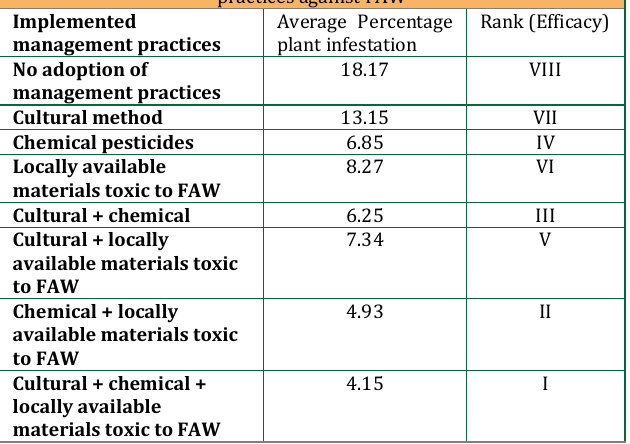
Table 5: Assessment of the efficacy of implemented management practices against FAW Implemented management